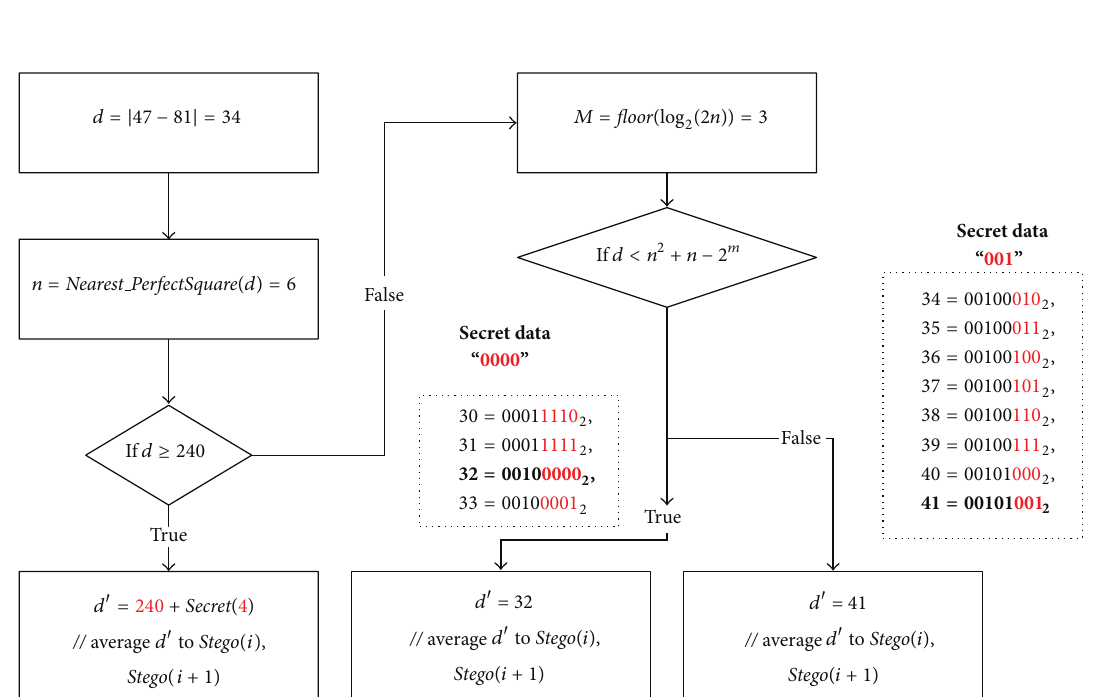
Figure 2: The embedding examples of two consecutive pixels (47,81) and two cases of secret data “0000” and “001”.